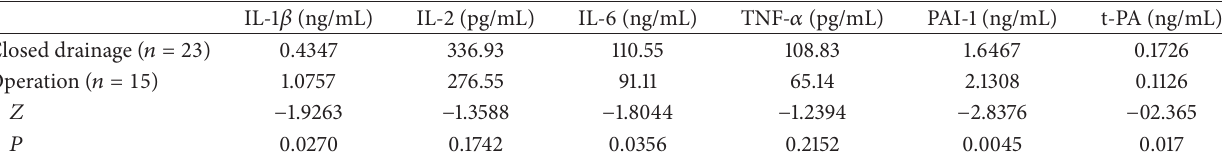
Table 2: IL-1 𝛽 , IL-2, IL-6, TNF- 𝛼 , PAI-1, and t-PA levels in the patients with tuberculous empyema treated by closed drainage and